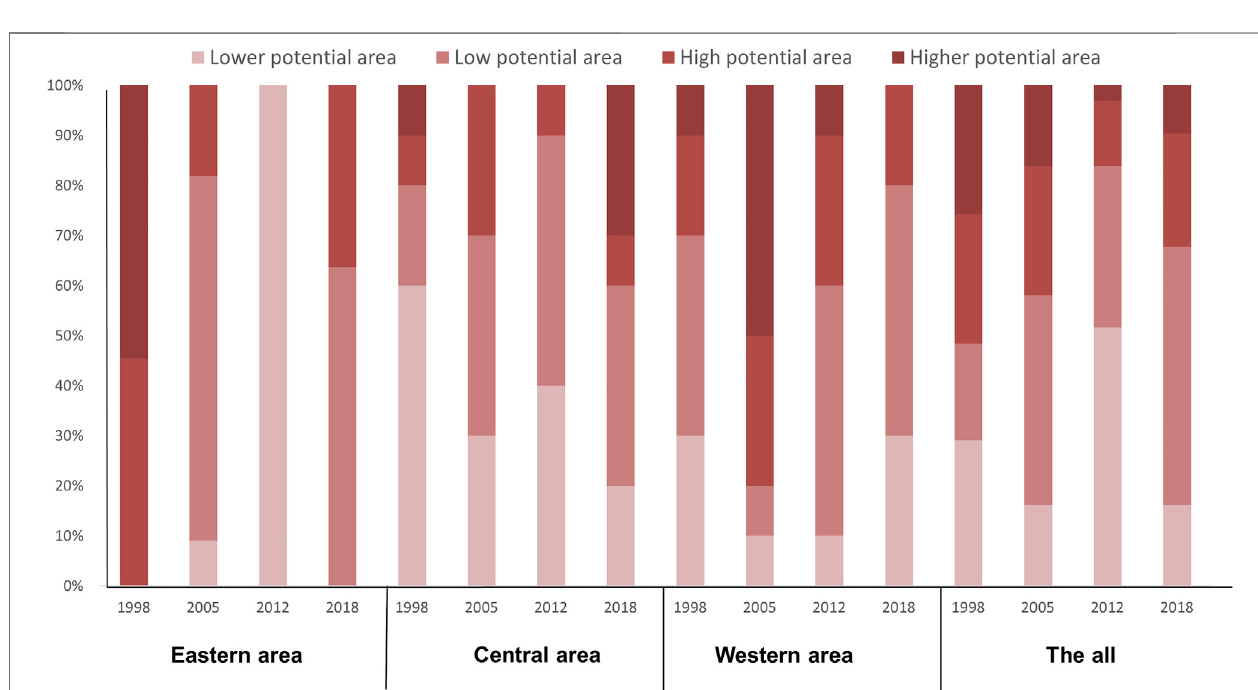
FIGURE 4 | Changes in the types of carbon emission reduction potential under agricultural green progress.